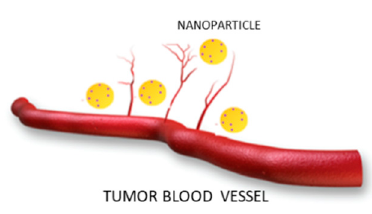
Figure 1. Behavior of nanoparticles in the blood vessels of the tumor area.